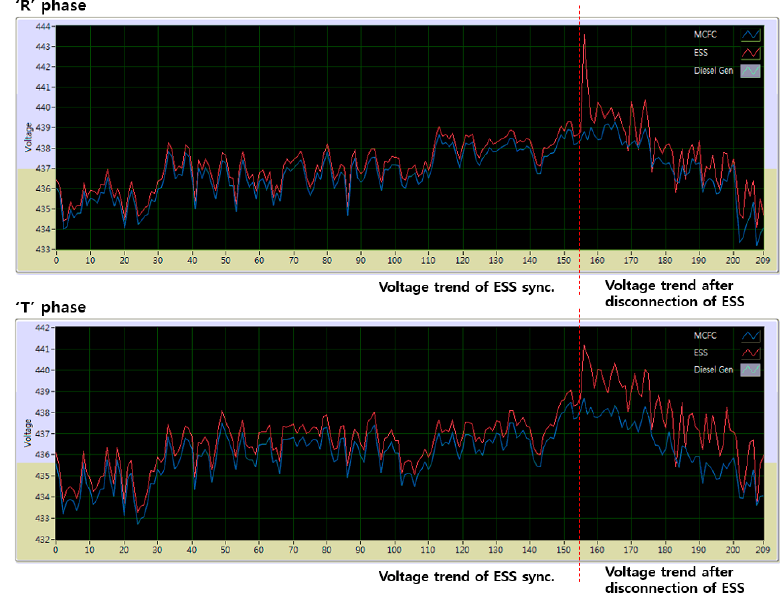
Figure 18. Voltage change when the ESS system was disconnected.